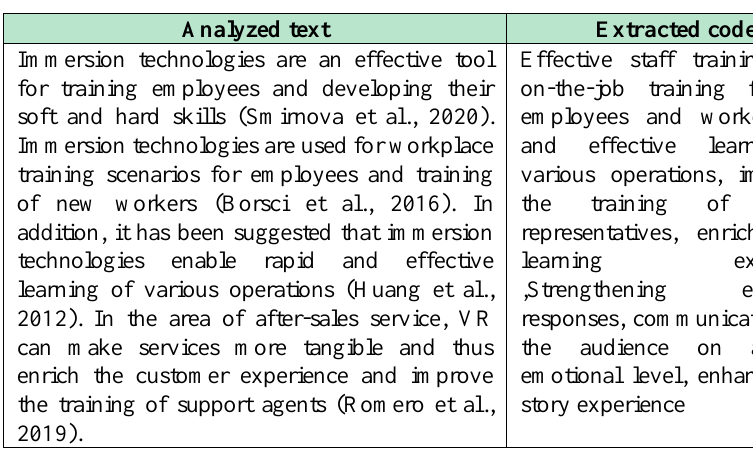
Table 1- Sample of coding the content of